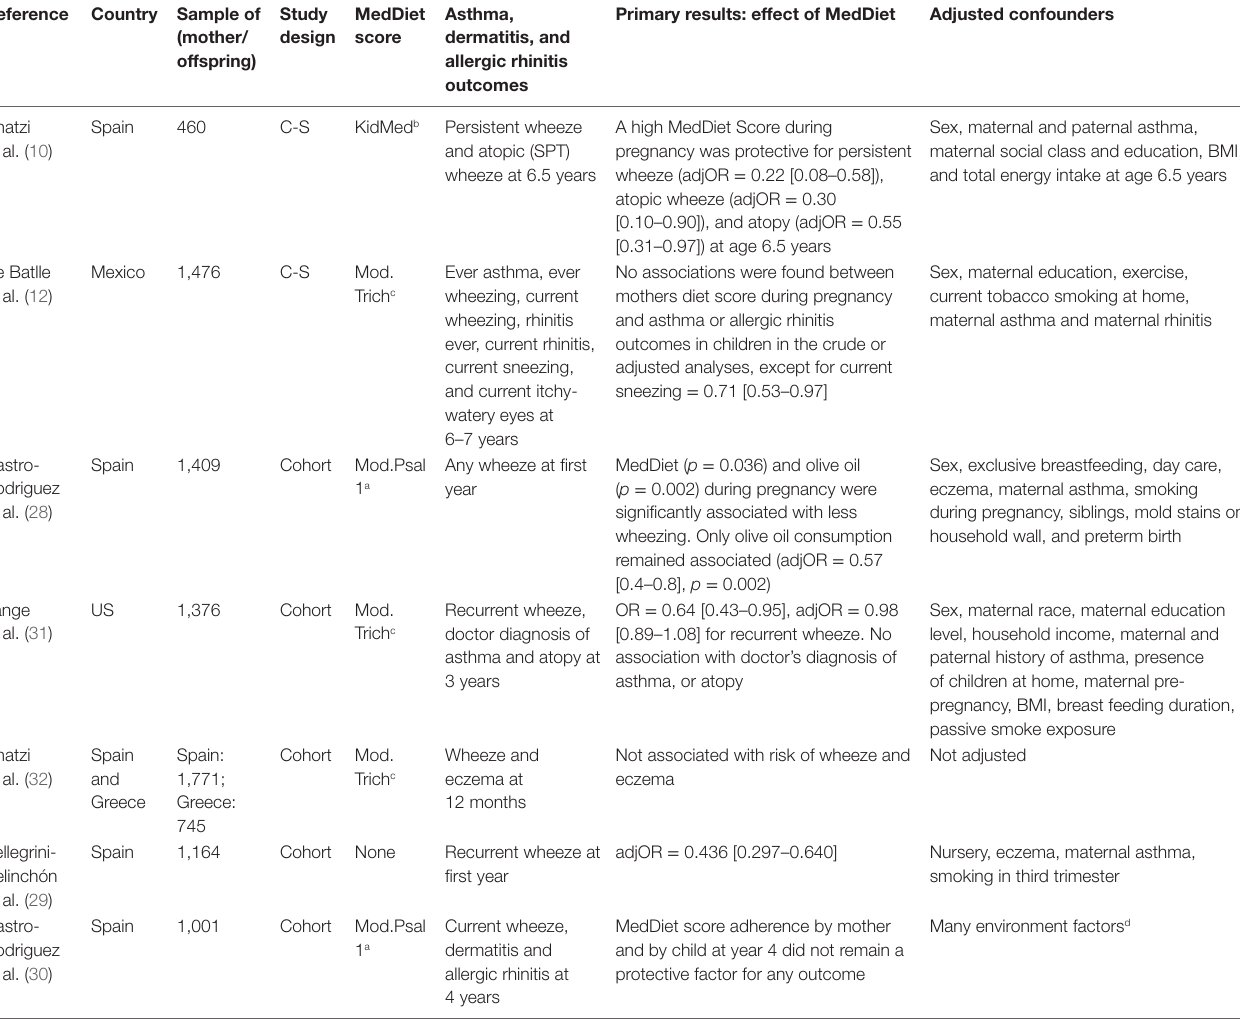
TAble 2 | Summary of studies reporting the association between adherence to MedDiet during pregnancy and asthma/wheezing/allergic disease in offspring. Reference Country Sample of